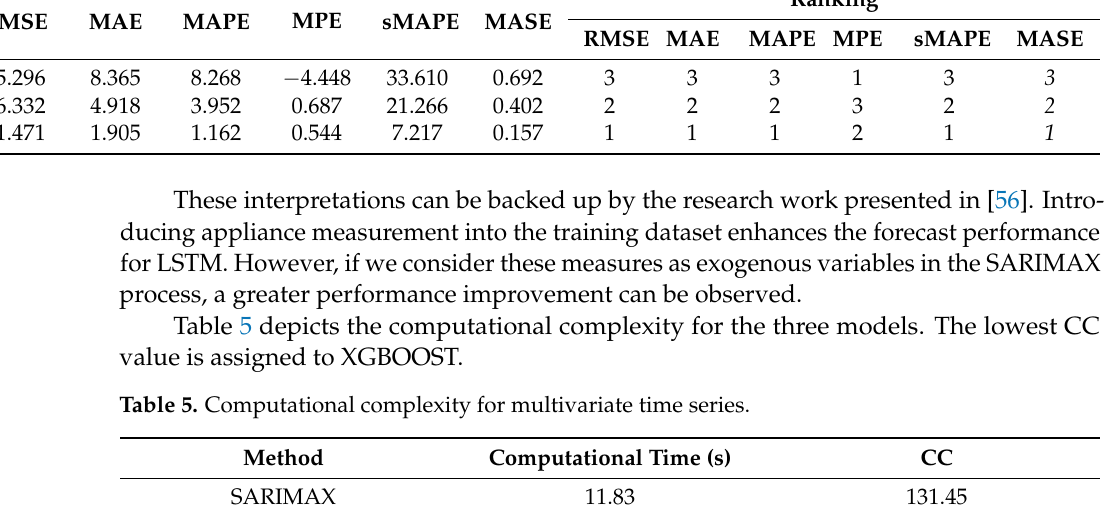
Figure 9. XGBOOST for multivariate time series. Table 4. Results & ranking of the performance metrics.